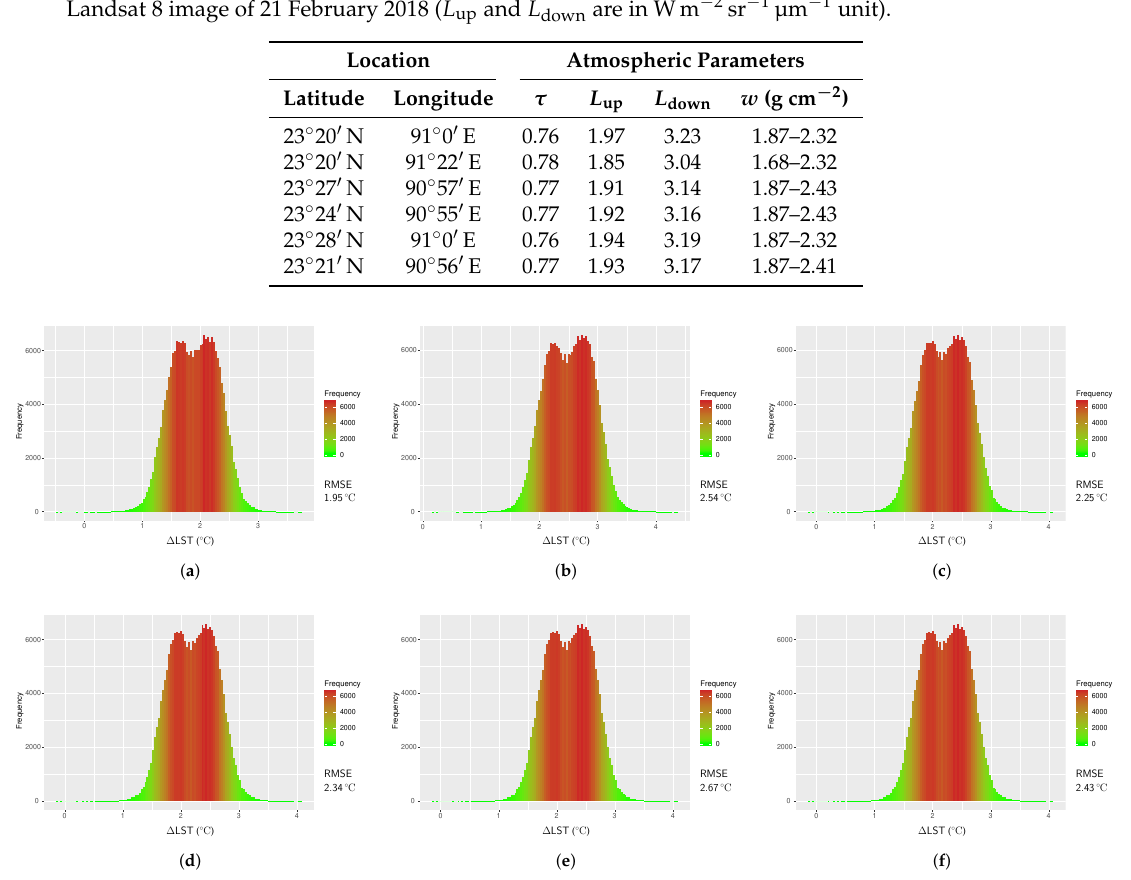
Figure 4. Histograms of temperature difference between the reference LST (LST ref ) and LST from Radiative Transfer Equation (RTE)-based algorithm (LST RTE ) for Landsat 8 image of 21 February 2018; ( a ) τ = 0.76, L up = 1.97, L down = 3.23, ( b ) τ = 0.78, L up = 1.85, L down = 3.04, ( c ) τ = 0.77, L up = 1.91, L down = 3.14, ( d ) τ = 0.77, L up = 1.92, L down = 3.16, ( e ) τ = 0.76, L up = 1.94, L down = 3.19, and ( f ) τ = 0.77, L up = 1.93, L down = 3.17 ( L up and L down are in Wm − 2 sr − 1 µm − 1